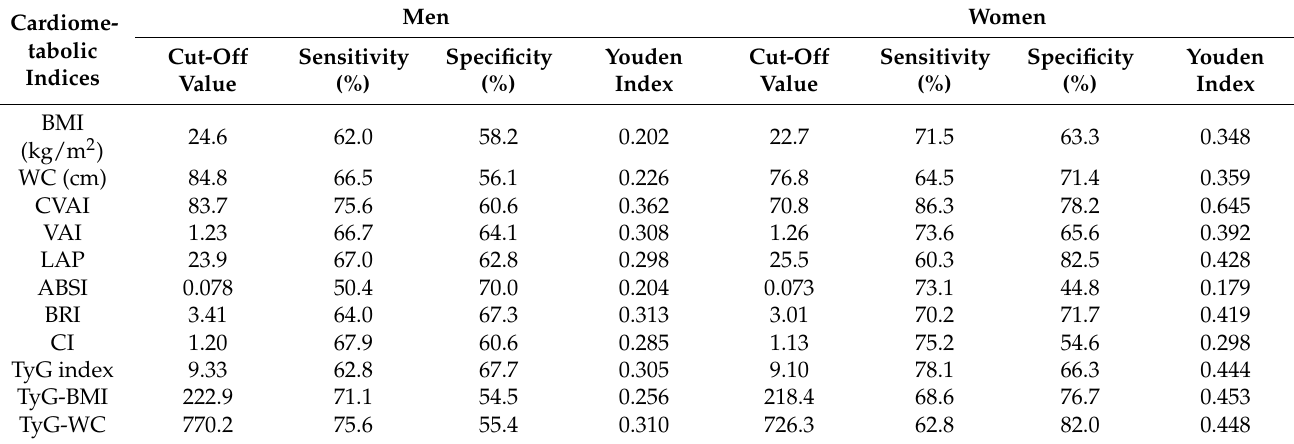
Table 3. The optimal cut-off value of CVAI was 83.7 for men and 70.8 for women. Table 3. Sensitivity, specificity, and Youden index using cut-off values for cardiometabolic indices to predict 10-year ASCVD risk ≥